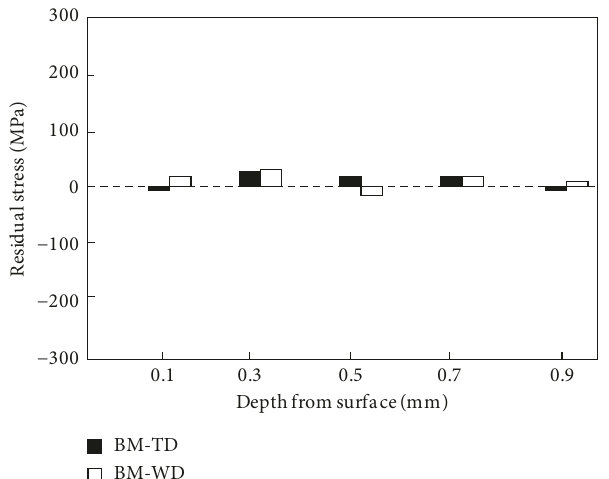
Figure 4: Residual stress distribution of the base metal.